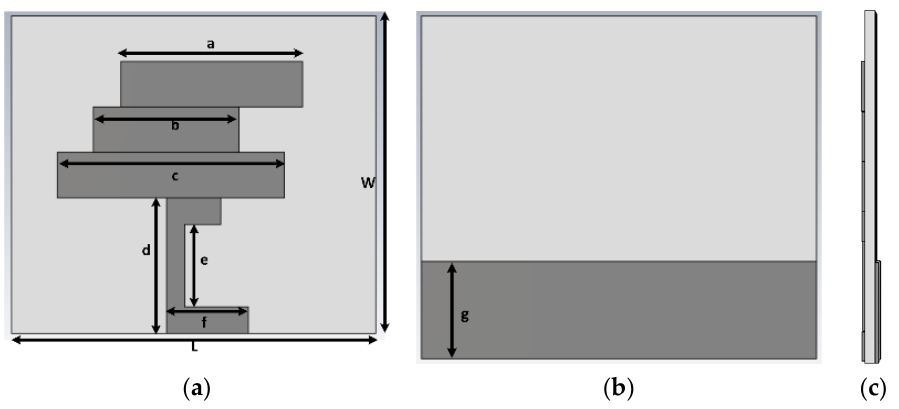
Figure 3. Design configuration of the proposed antenna: ( a ) front view; ( b ) back view; and ( c ) cross-sectional view.